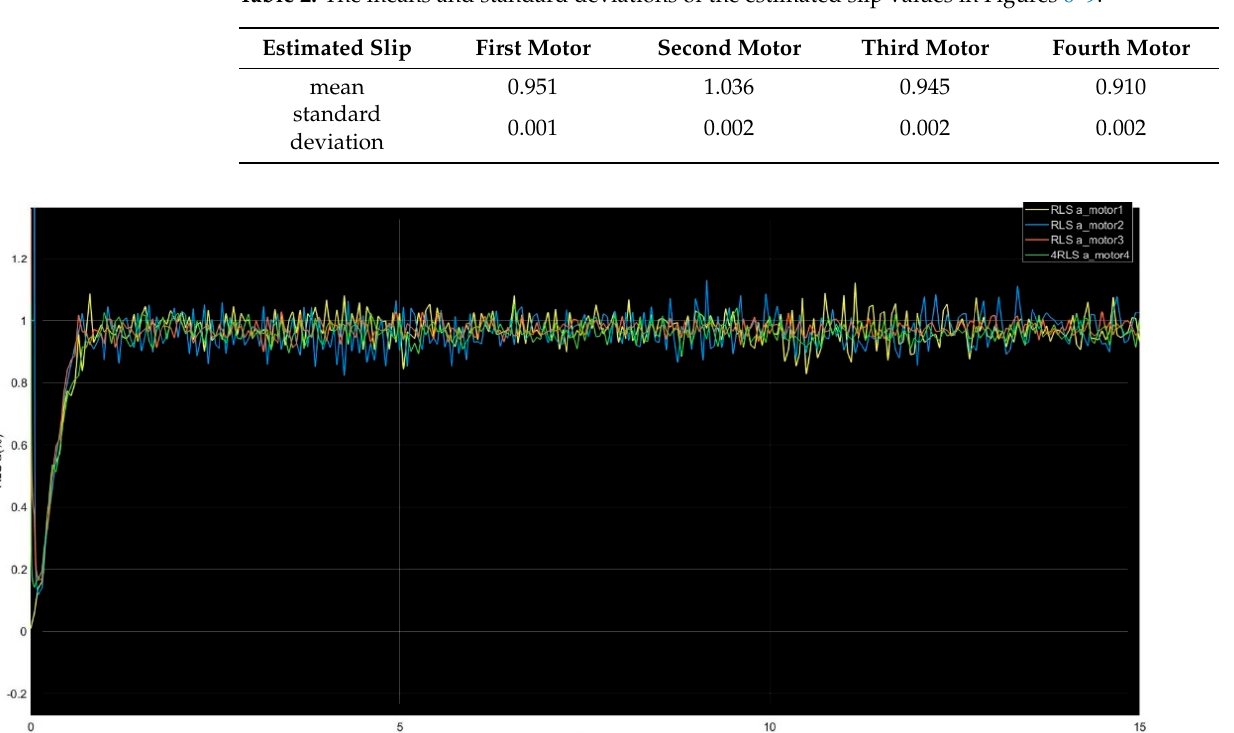
Table 2. The means and standard deviations of the estimated slip values in Figures 6–9.